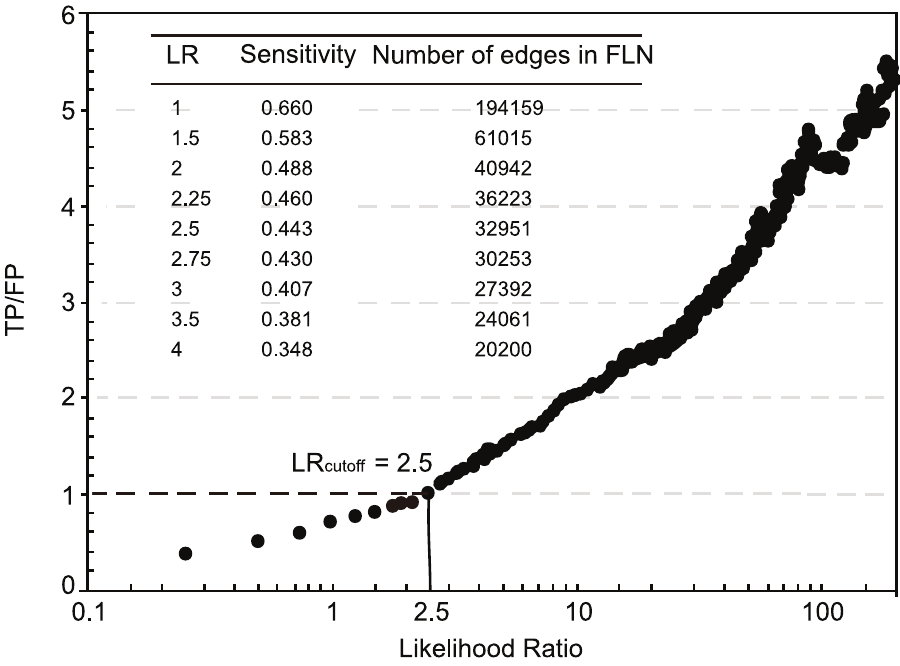
Figure 4. TP/FP ratios vs. LR cutoff, and corresponding sensitivity. TP: True Positive; FP: False Positive. Sensitivity=TP/(TP + FN).